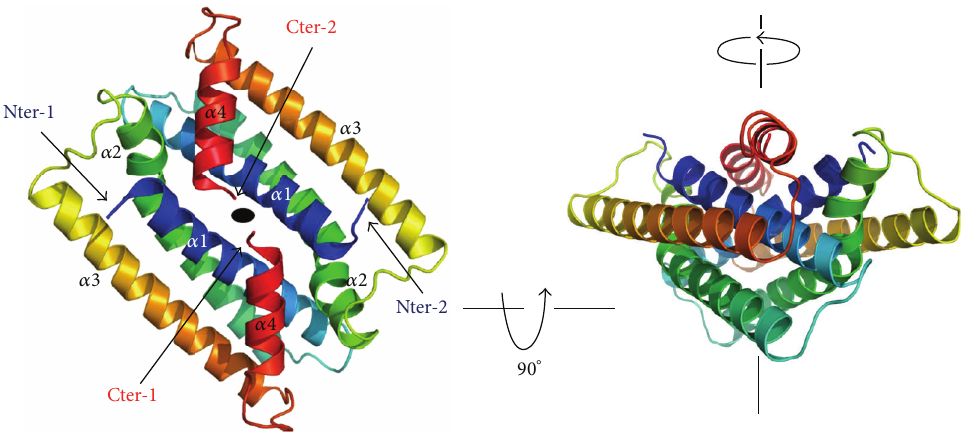
Figure 1: Two perpendicular views of the X-ray structure of the PAV1-137 dimer. The two subunits are represented in rainbow colouring going from blue (N-terminal) to red (C-terminal). The N and C terminus and the helices of the two subunits are labelled. The two-fold axis is